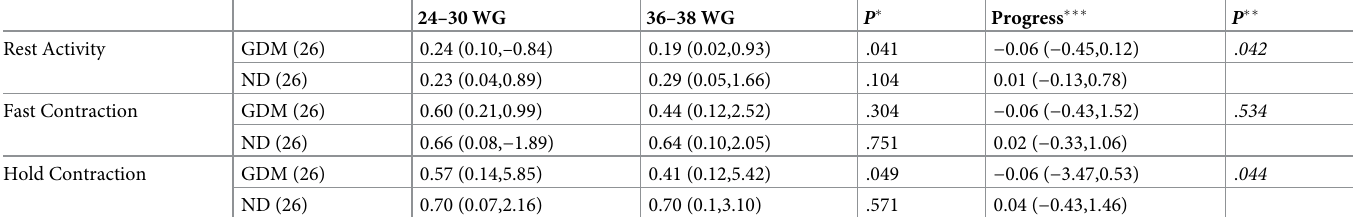
WG = weeks of gestation; Data are the median (minimum, maximum) range. �